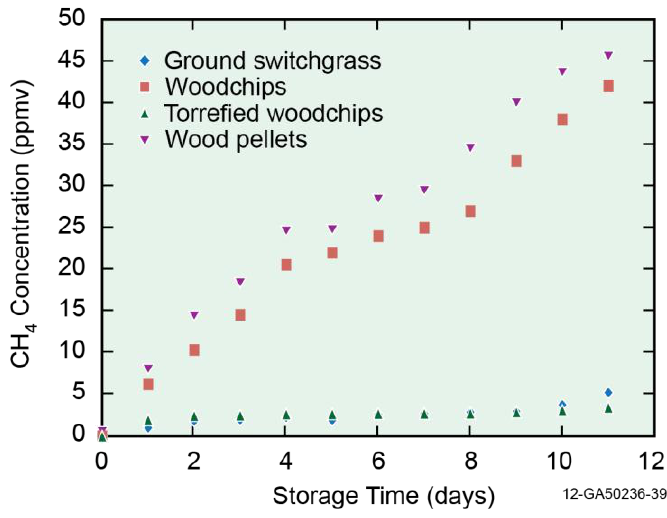
Figure 5. CO 2 concentration at 40 °C storage temperature.